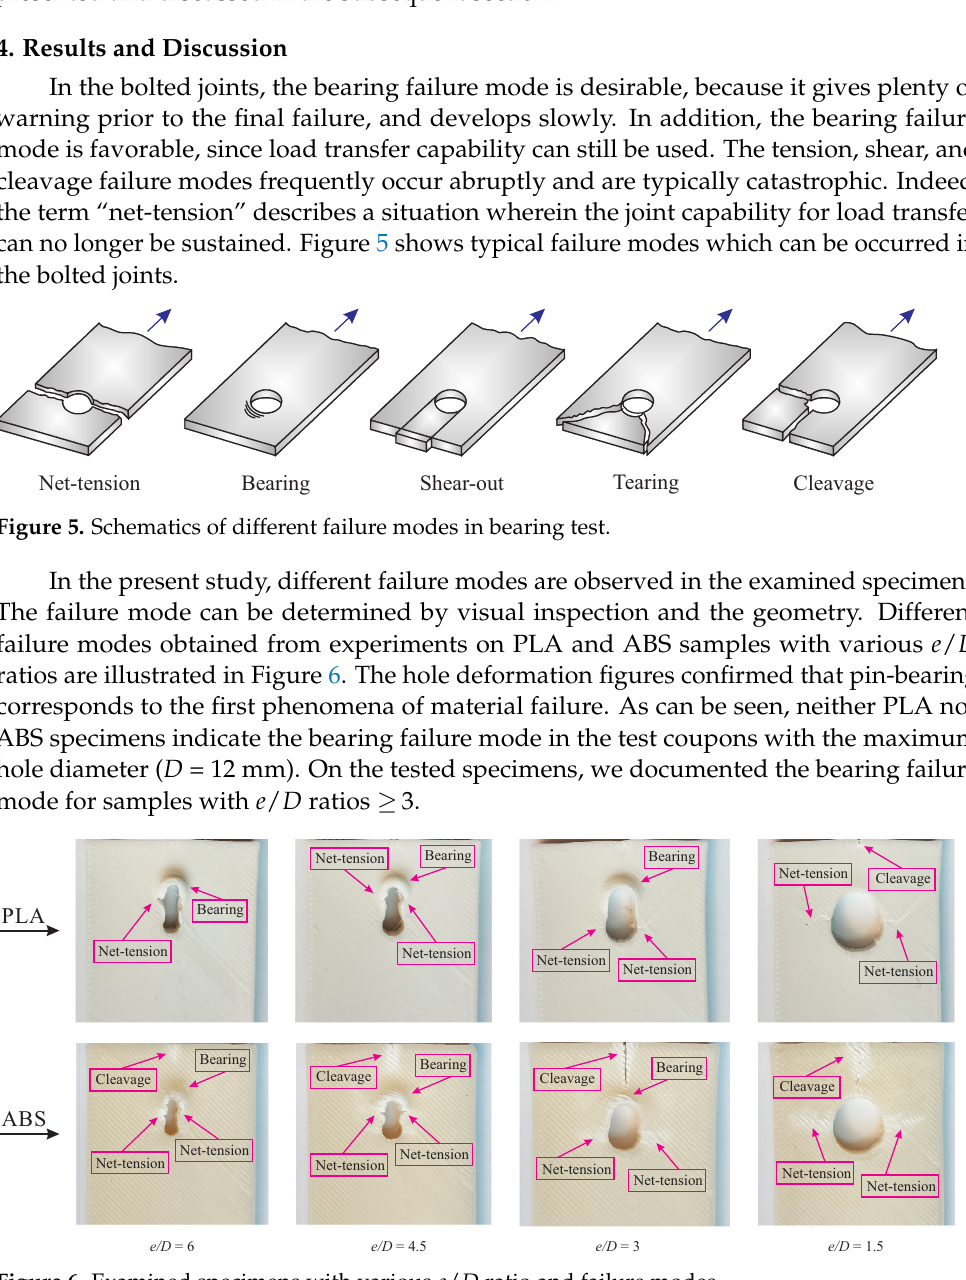
Figure 6. Examined specimens with various e / D ratio and failure